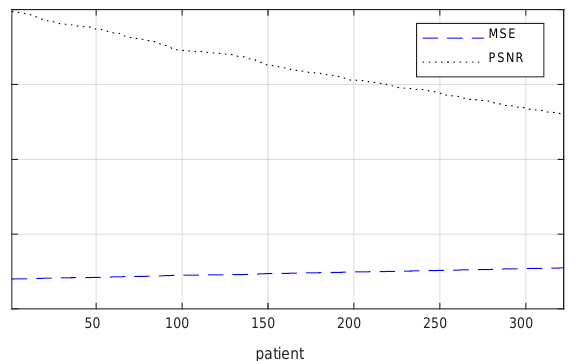
Figure 11. Performance measures MSE and PSNR when embedded shares are compared with the original shares for all mammograms of mini-MIAS.